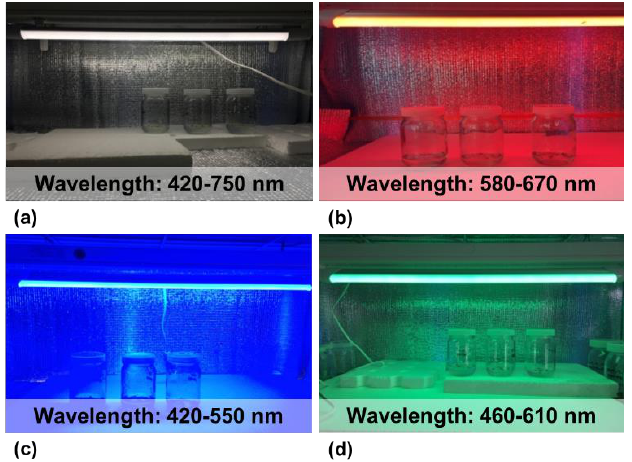
Figure 1. The application of monochromatic white ( a ), red ( b ), blue ( c ), and green ( d ) LEDs with specific wavelengths (white LED; 420 – 750 nm, red LED; 580 – 670 nm, blue LED; 420 – 550 nm, and specific wavelengths (white LED; 420–750 nm, red LED; 580–670 nm, blue LED; 420–550 nm, and green LED; 460 – 610 nm) for in vitro PLB proliferation. green LED; 460–610 nm) for in vitro PLB